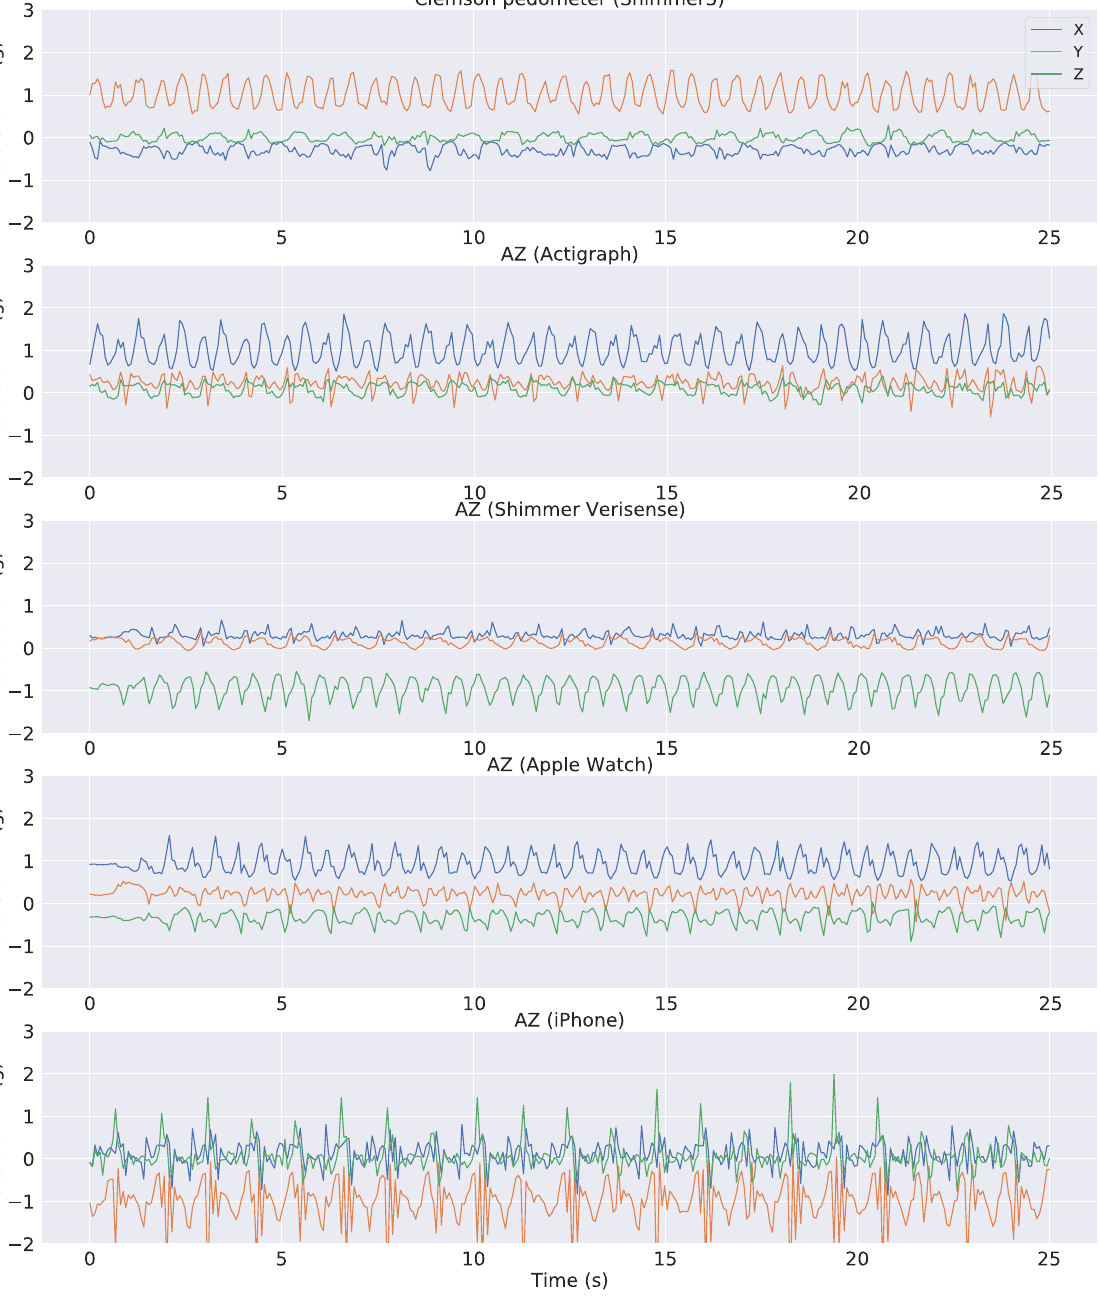
Figure 2. Representative raw accelerometer data from public and independent datasets. The first panel indicates data from the public Clemson dataset. The other panels illustrate AstraZeneca dataset for different devices used in the